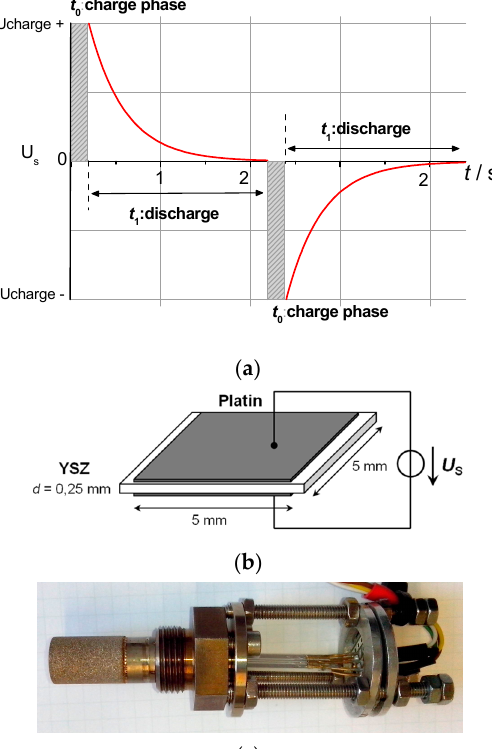
Figure 1. ( a ) schematic depiction of the charge and discharge phases during pulsed polarization; ( b ) schematic depiction of the YSZ based sensor element consisting of a YSZ substrate and screen printed Pt electrodes; ( c ) Sensor probe as used in the engine tests, overall length is 12